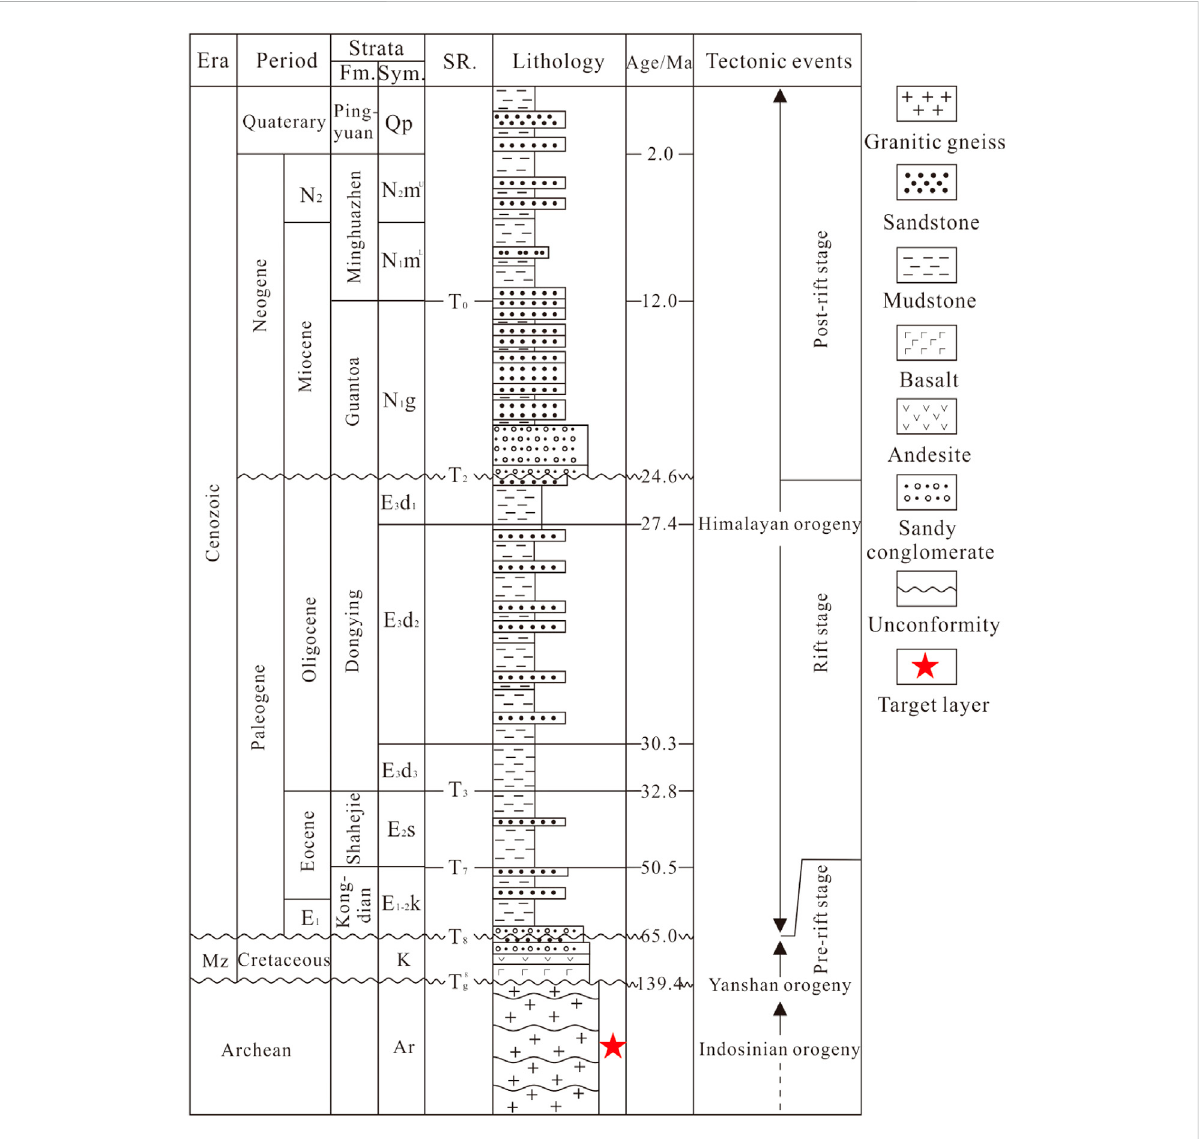
FIGURE 2 Stratigraphic column in the study area, showing the lithology and tectonic event (modi fi ed after Zhao et al., 2020). Fm.=Formation; Sym.=Submember; SR.=Seismic reference; Mz=Mesozoic; E 1 =Paleocene; N 2 =Pliocene.